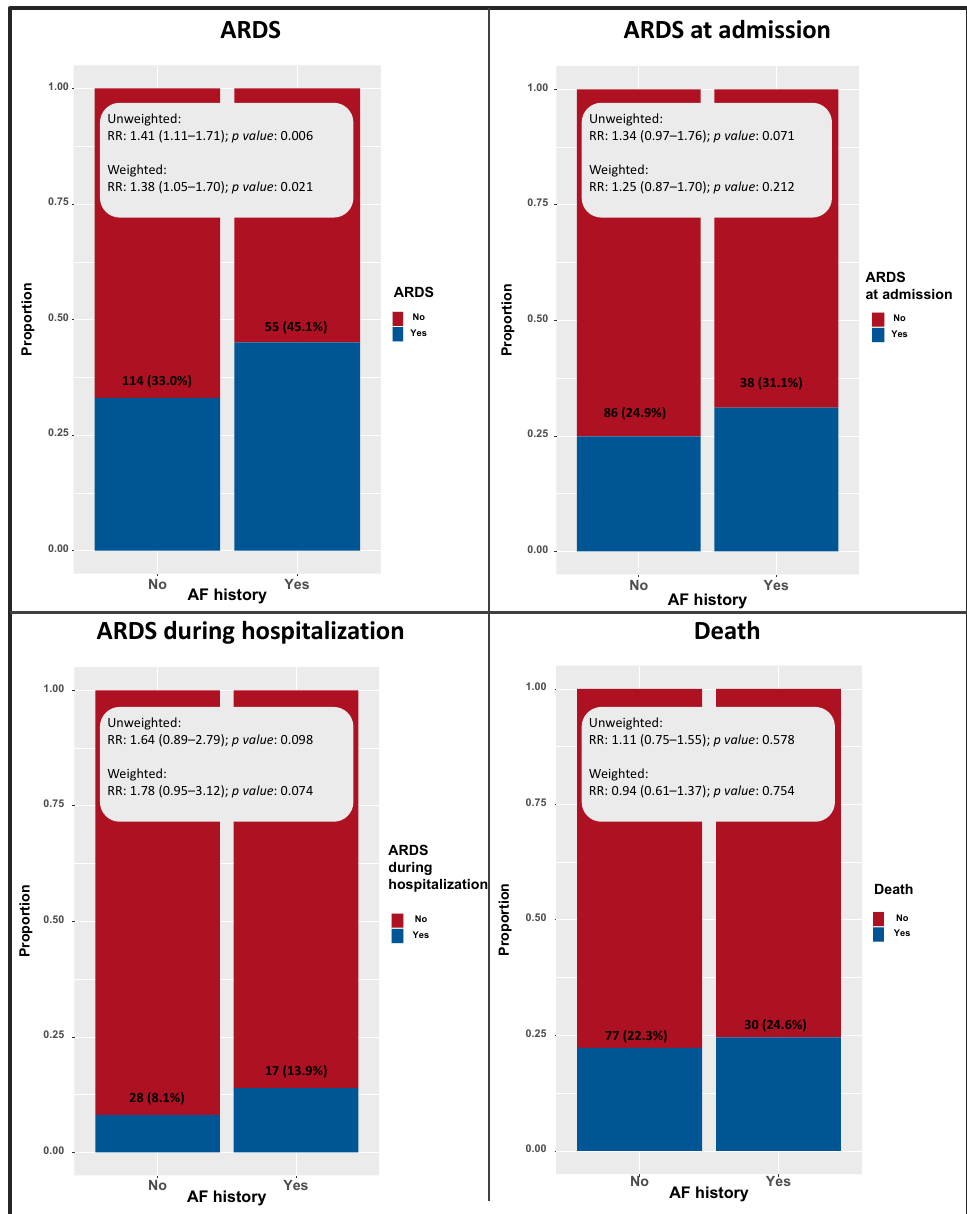
Figure 3. Prevalence and risk ratio of the outcome of interest among patients with and without AF history.